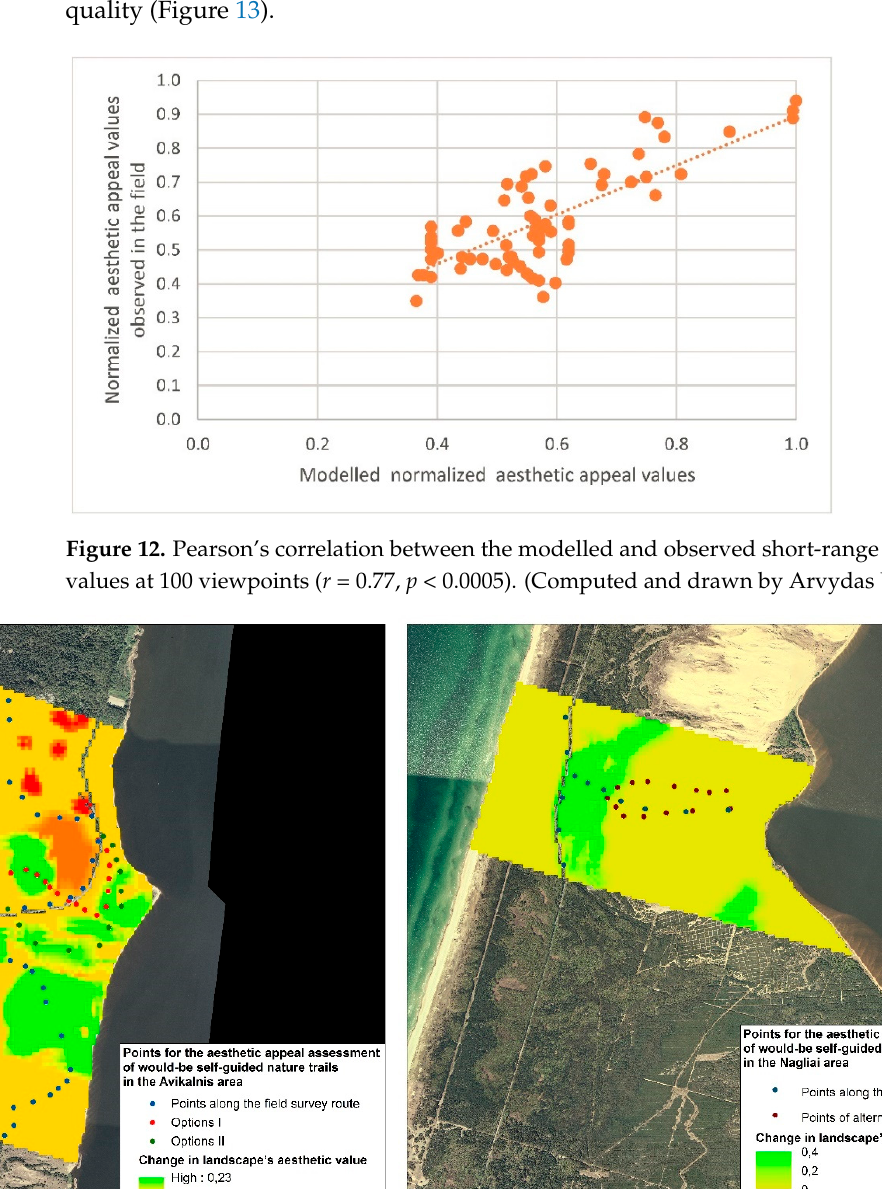
Figure 12. Pearson’s correlation between the modelled and observed short ‐ range aesthetic appeal values at 100 viewpoints ( r = 0.77, p < 0.0005). (Computed and drawn by Arvydas Urbis).